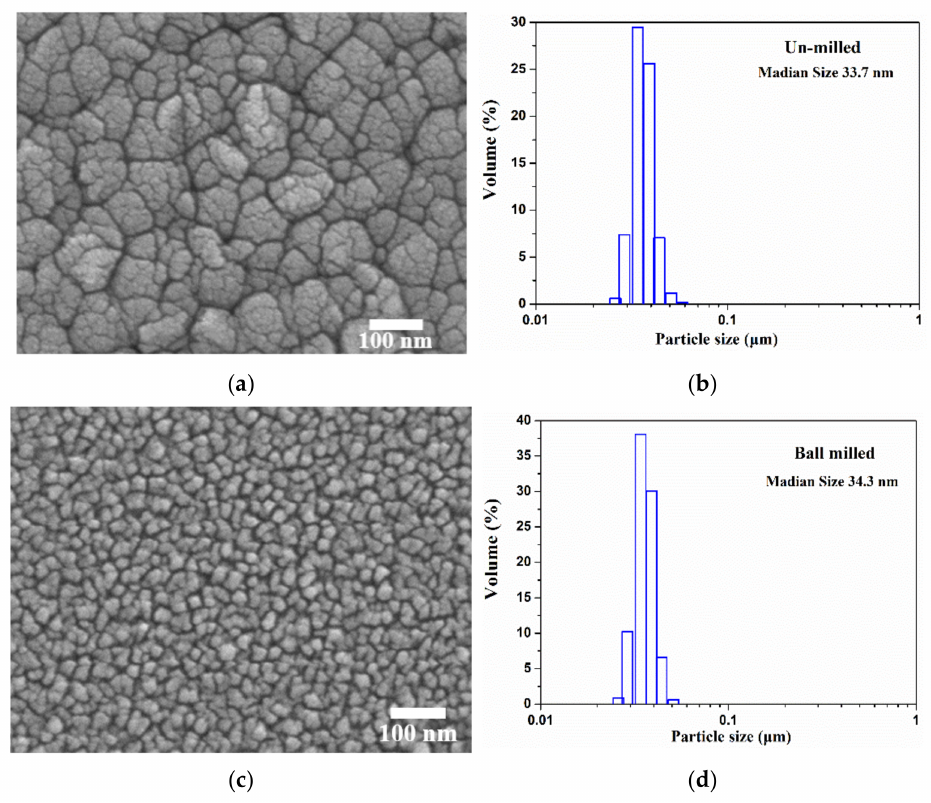
Figure 4. SEM (left) and laser scattering (right) images for particle size of TiO 2 powders: ( a , b ) un-milled and ( c , d ) ball milled samples.